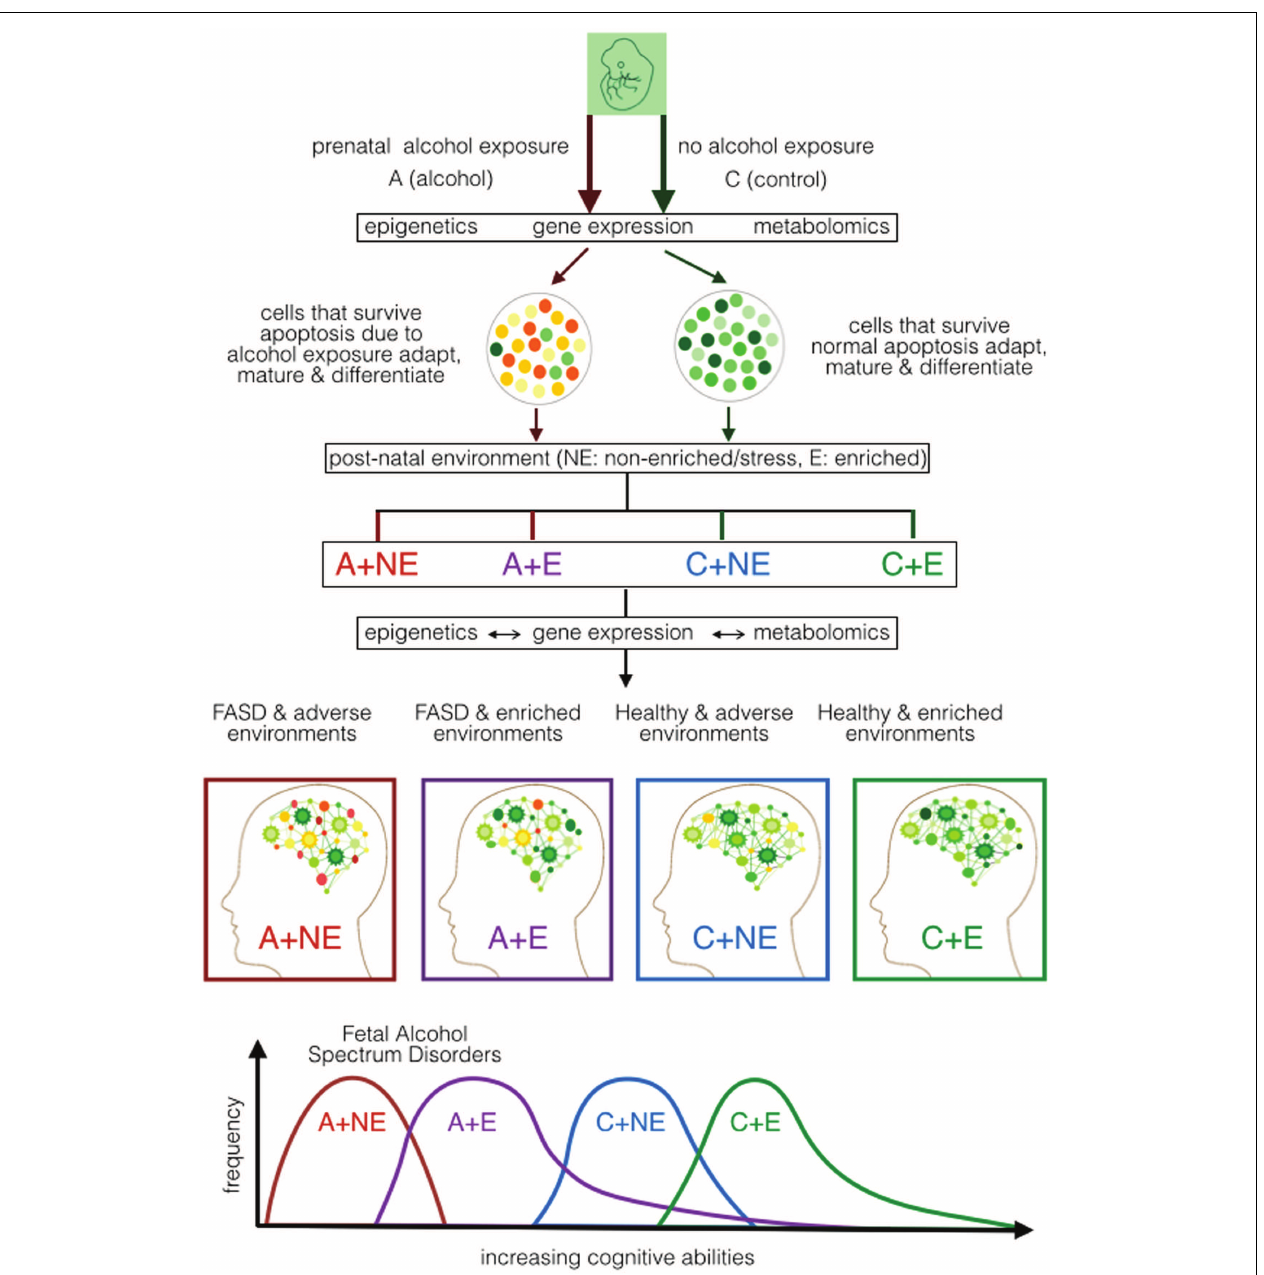
conditions on epigenetic, gene expression, and metabolomics during post-natal development.The expected cognitive ability of the mice subjected to the four treatment combinations (A–NE, A–E, C–NE, and C–E) is projected. It suggests that the post-natal environment is capable of ameliorating (at least partly) the effect of prenatal alcohol and other effects that may affect mental ability of the